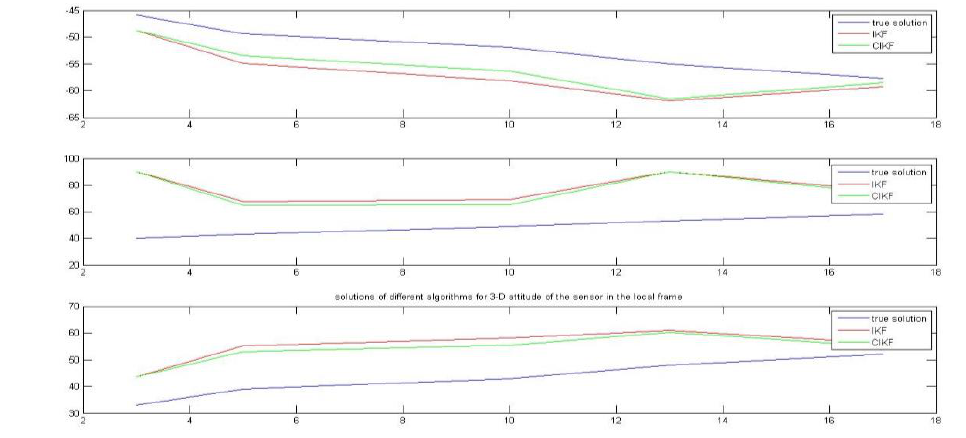
Figure 8: solutions of the CIKF and IKF algorithms for 3-D attitude of the mobile sensor in a local frame